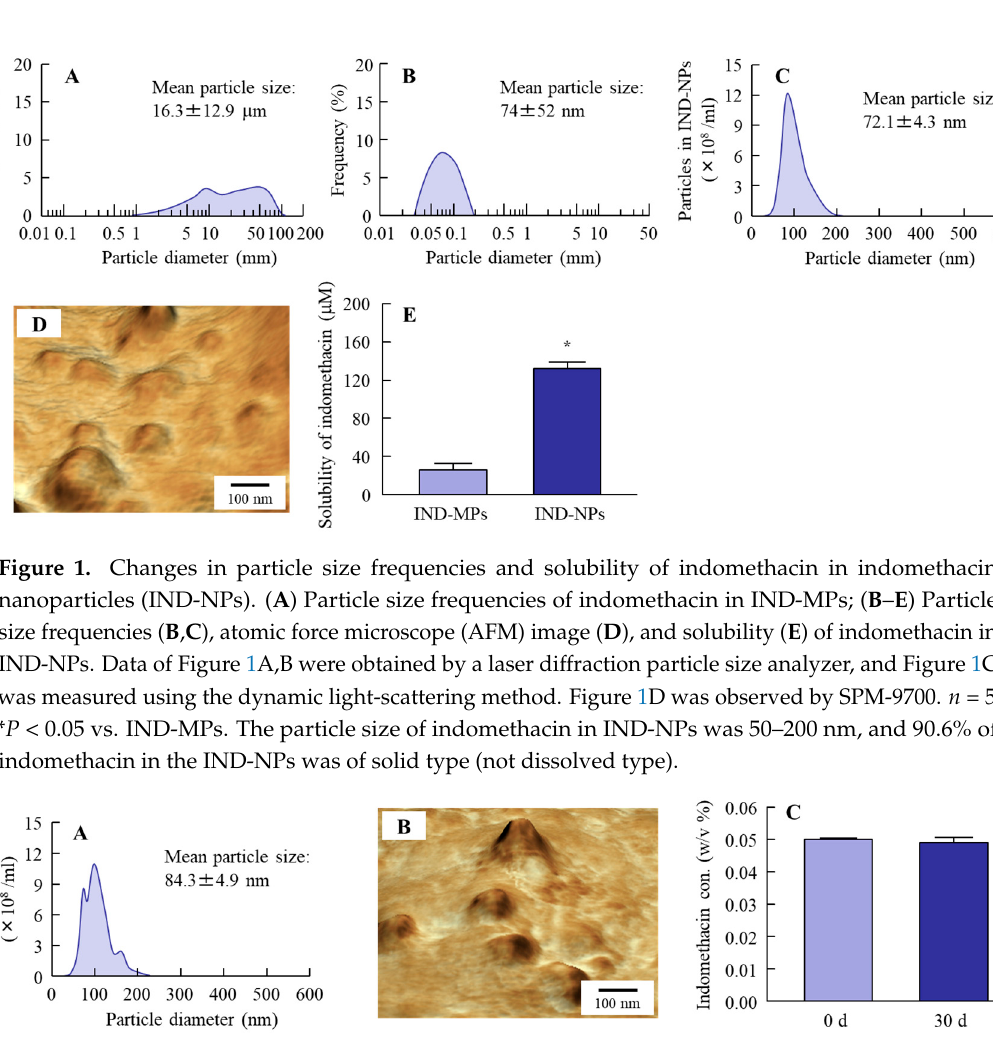
Figure 1. Changes in particle size frequencies and solubility of indomethacin in indomethacin nanoparticles (IND-NPs). A : Particle size frequencies of indomethacin in IND-MPs; B – E : Particle size frequencies ( B and C ), atomic force microscope (AFM) image ( D ), and solubility ( E ) of indomethacin in IND-NPs. Data of Figure 1 A , B were obtained by a laser diffraction particle size analyzer, and Figure 1C was measured using the dynamic light-scattering method. Figure 1D was observed by SPM-9700. n = 5. * P <0.05 vs. IND-MPs. The particle size of indomethacin in IND-NPs was 50–200 nm, and 90.6% of indomethacin in the IND-NPs was of solid type (not dissolved type).